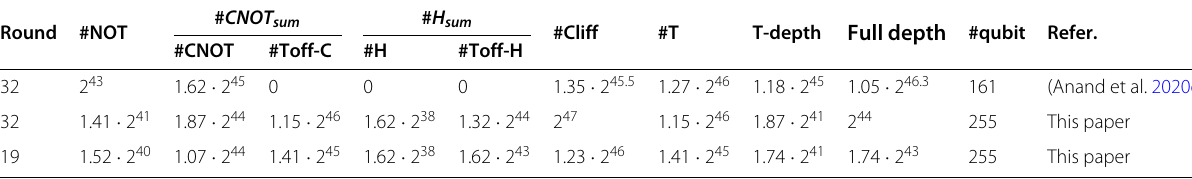
Table 6 The cost of quantum exhaustive search on